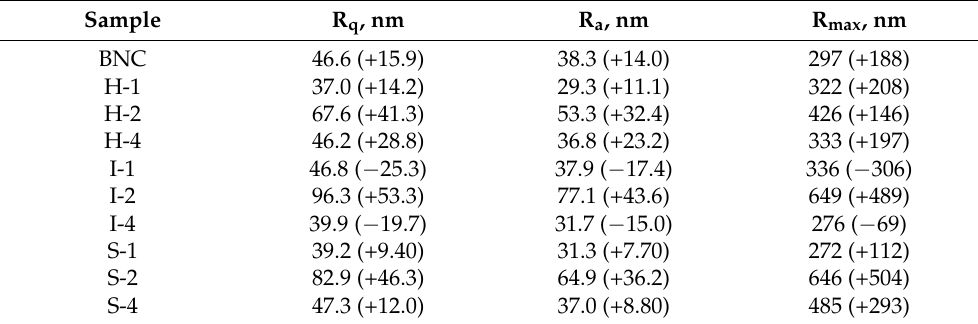
Table 2. Parameters R q , R a , and R max of UV-treated BNC and BNC/PVA blends obtained by various methods. The difference between the values in relation to the non-irradiated samples is given in parentheses 1 .